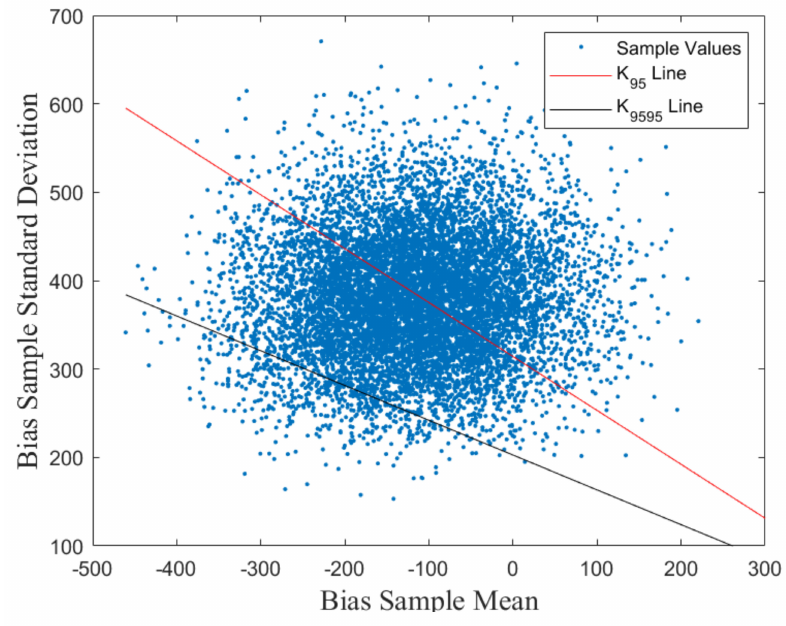
Figure 8. Tolerance limit upper threshold determination.